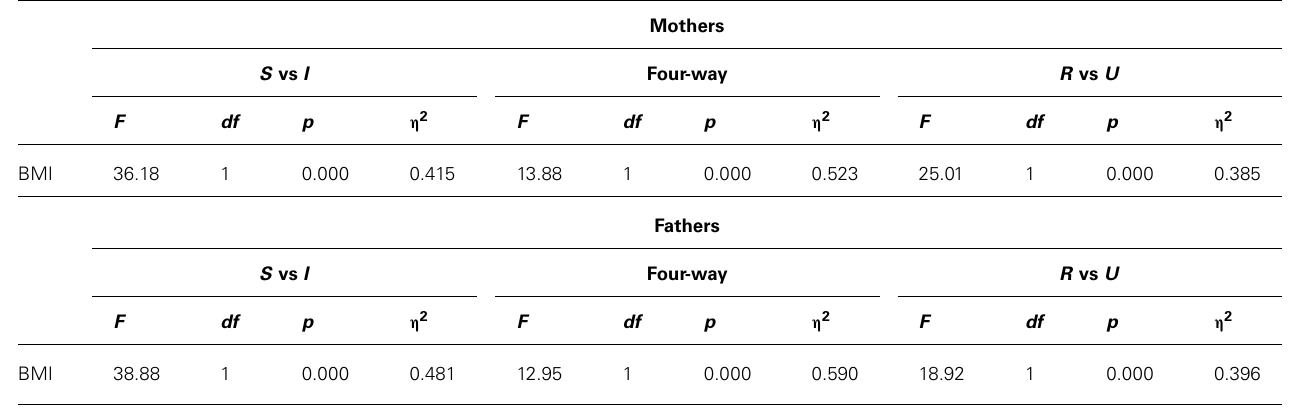
Table 2 |Analysis of variance (ANOVA) for mothers’ and fathers’ attachment on child’s BMI.